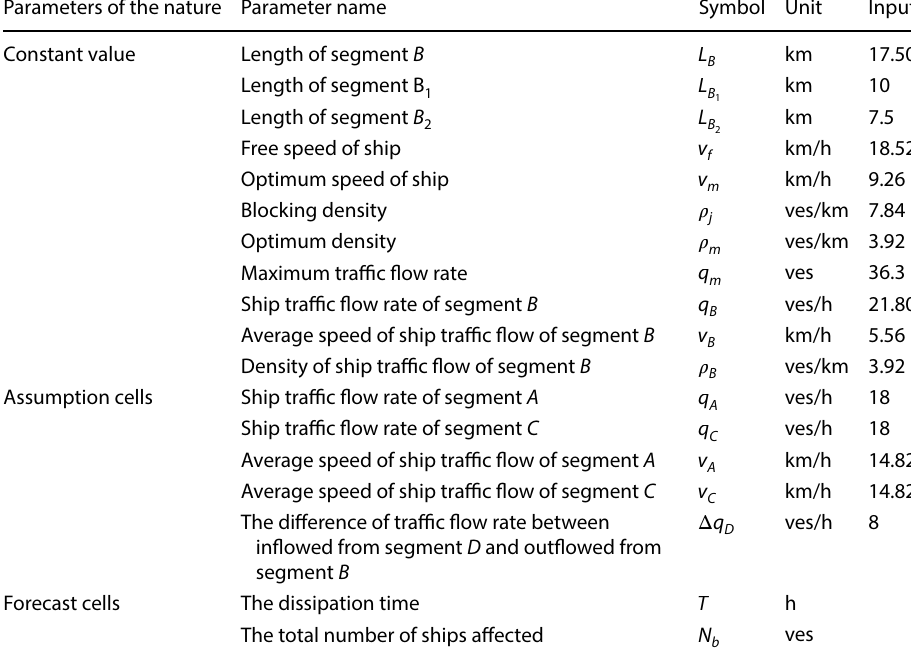
* q , q , v , v , Δ q are mean values, and obey A C A C D